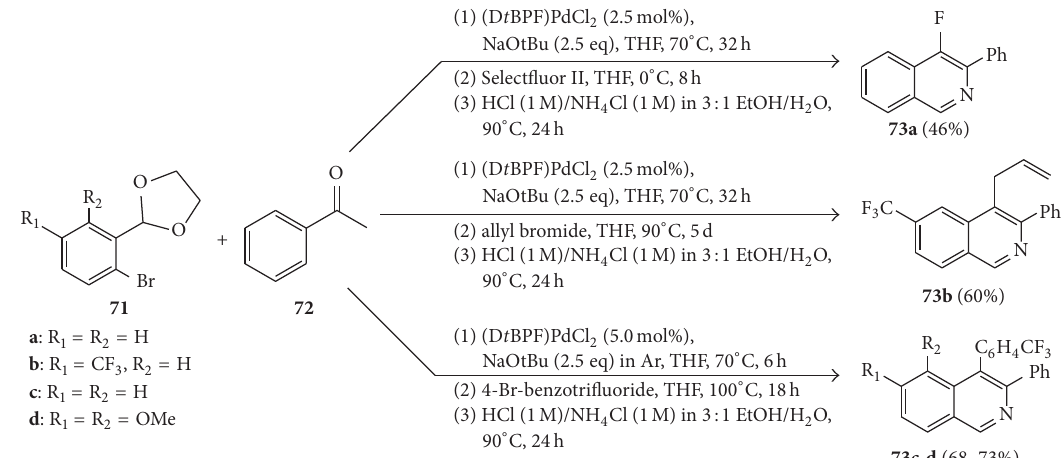
Scheme 17: Di-t-butylphosphinoferrocene-based palladium catalyzed fluoroisoquinoline and trifluoromethylisoquinoline